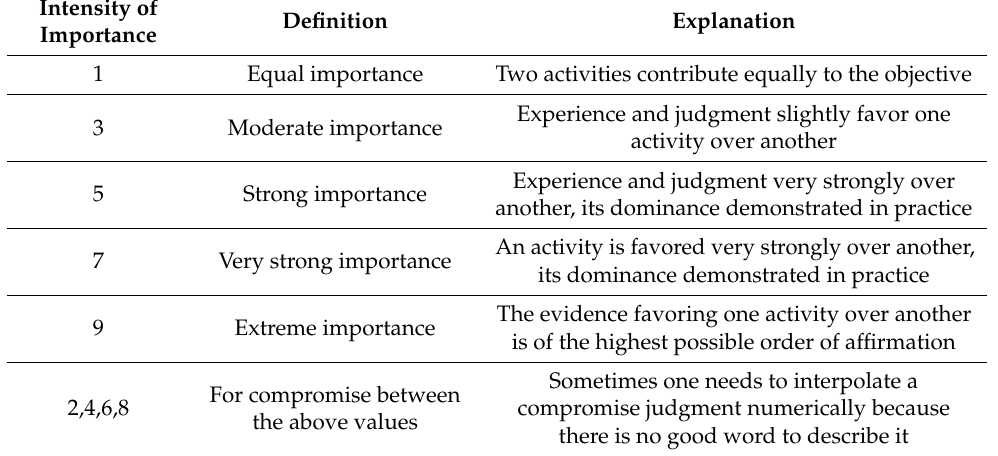
Table 1. The Fundamental Scale of